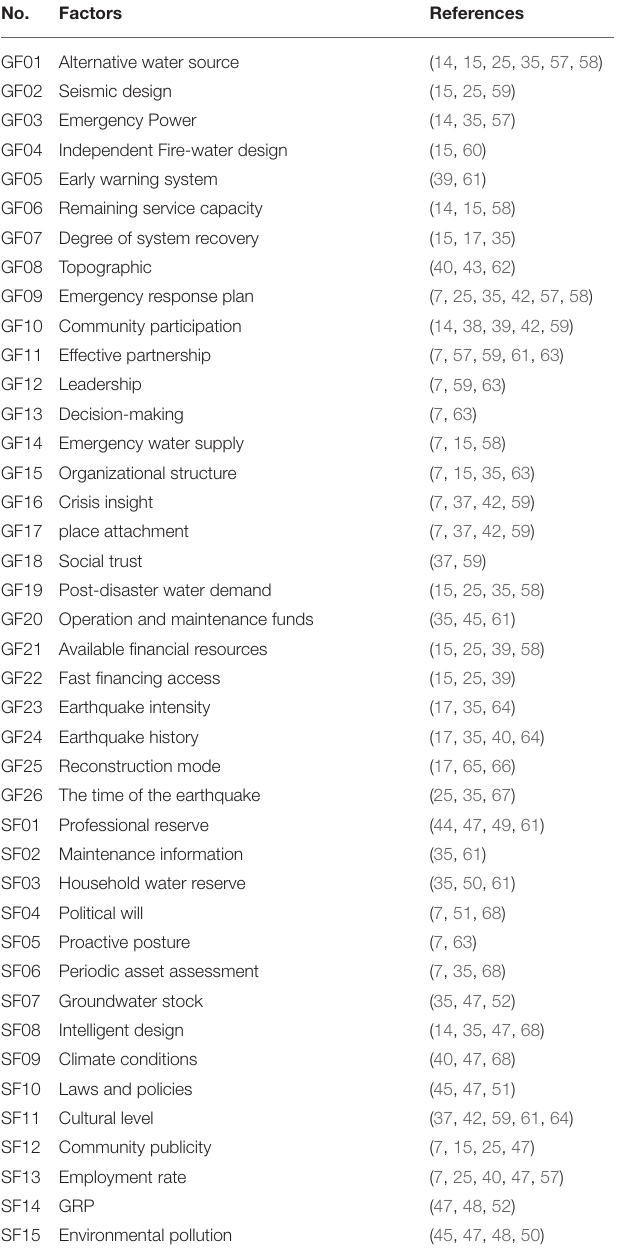
TABLE 2 | List of potential factors affecting seismic-resilience of RWSSs.